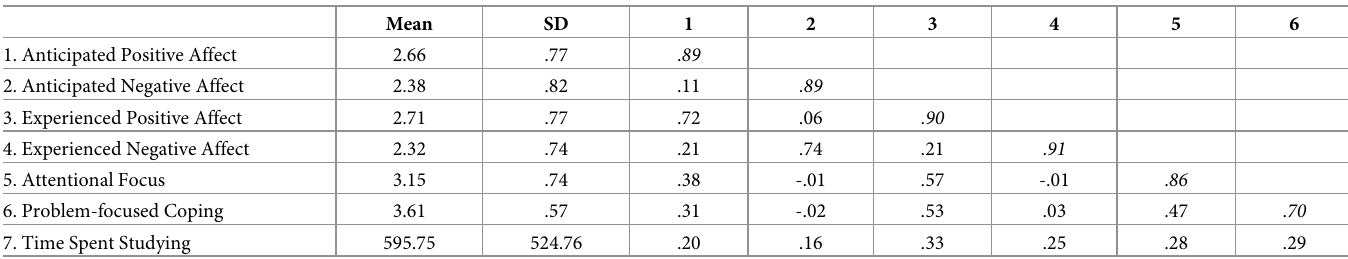
Table 1. Study 2 descriptive statistics and correlations.